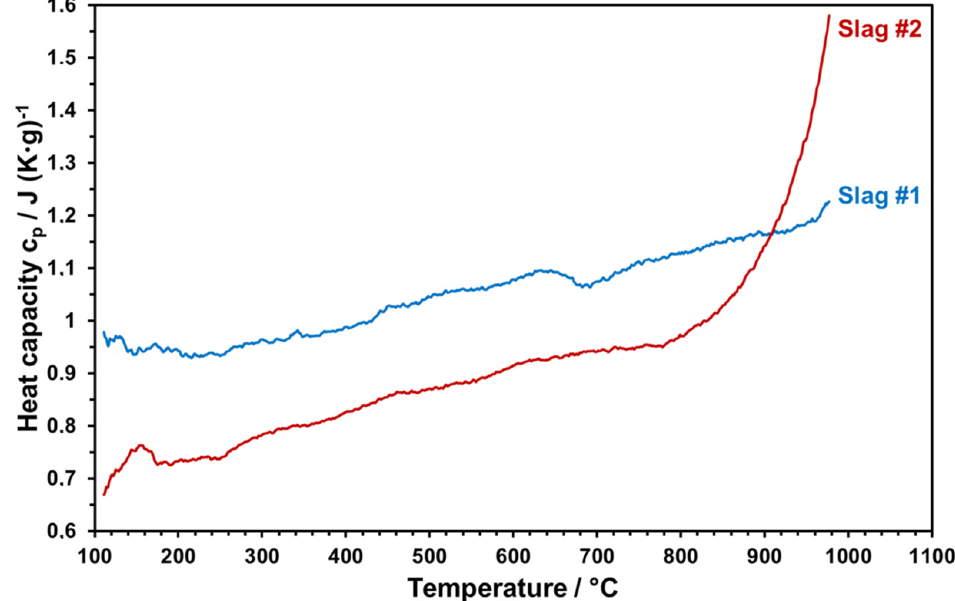
Figure 17. Heat capacity of the slags as a function of temperature.